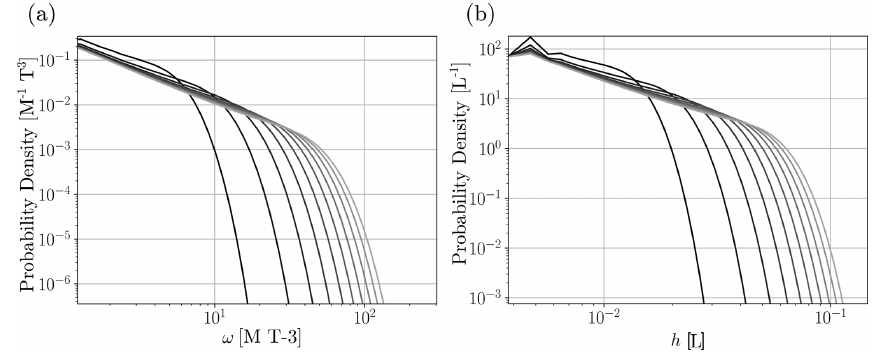
Figure 9. Probability density functions for (a) ω and (b) h for hillslopes with L h from 10 to 200 by increments of 10. Longer hillslopes are lighter colors. The distribution is not smooth for small values of h because of the discrete